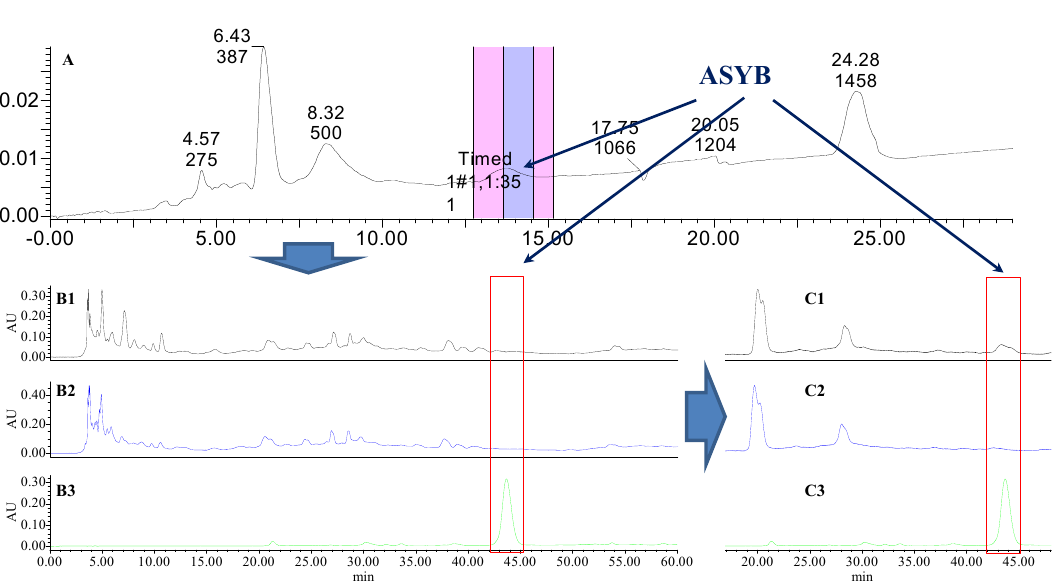
Molecules 2016 , 21 , 1480 Figure 11. The preparative and analytical chromatograms of the depletion of ASYB from CF-AS. ( A ) preparative chromatogram at 270 nm; ( B1 ) analytical chromatogram of CF-AS at 270 nm; ( B2 ) analytical chromatogram of CF-AS-B at 270 nm; ( B3 ) analytical chromatogram of ASYB depleted from CF-AS at 270 nm. ( C1 ) analytical chromatogram of CF-AS at 400 nm; ( C2 ) analytical chromatogram of CF-AS-B at 400 nm; ( C3 ) analytical chromatogram of ASYB depleted from CF-AS at 400 nm.